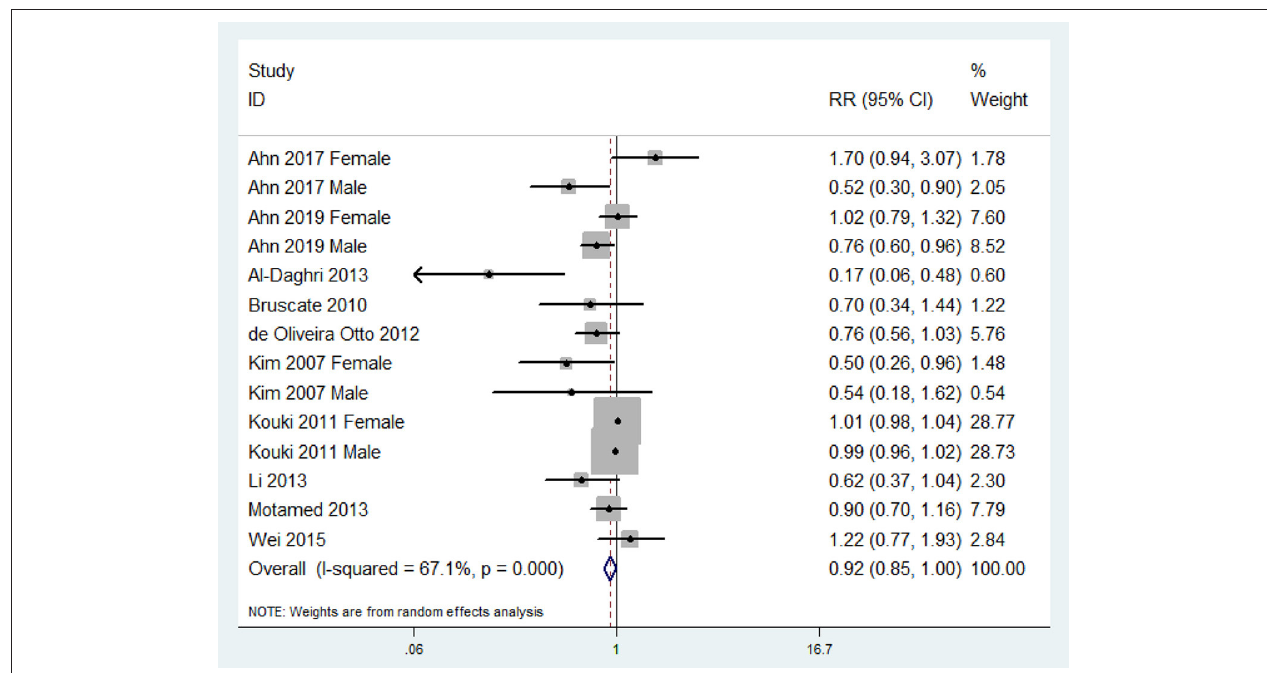
FIGURE 2 | Forest plot of meta-analysis: Overall multi-variable adjusted RR of MetS for the highest vs. lowest category of dietary vitamin E level.